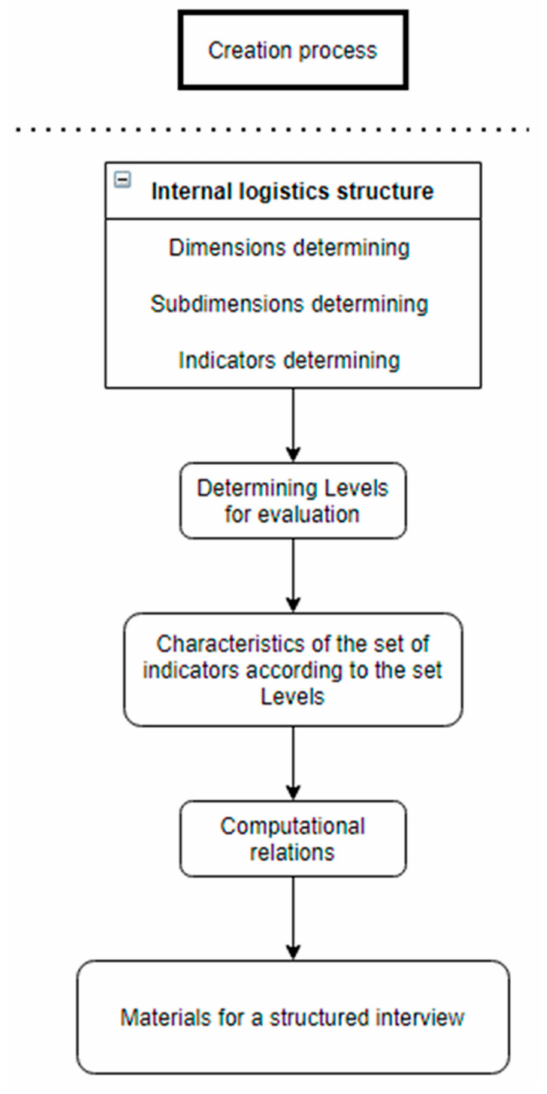
Figure 1. Methodology